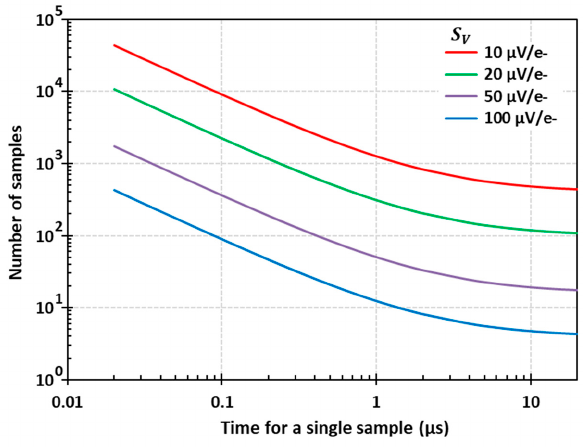
Figure 4. Number of averaged samples for 0.15 e ‐ RMS ENC for different conversion gains as a function of the time required for a single sample for e nw = 30 nV/ Hz and f nc = 330